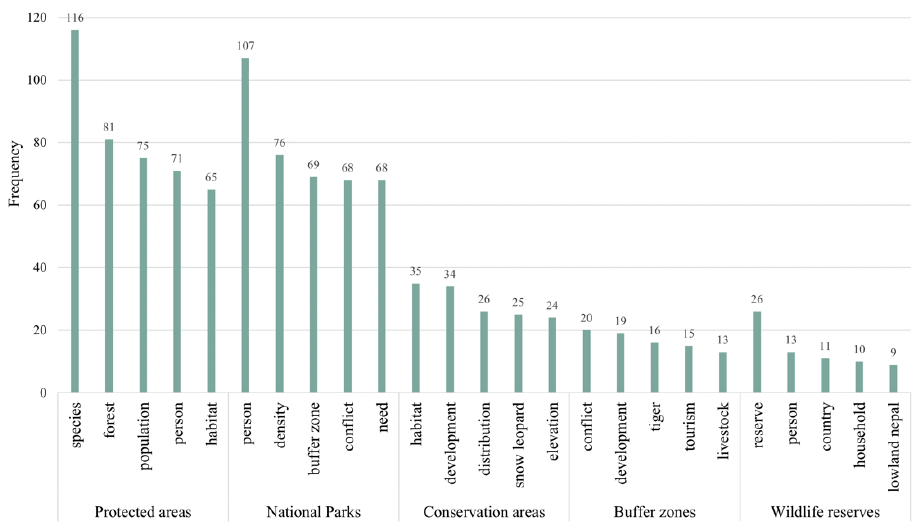
Figure 16. Comparison of top five keywords under each topic.